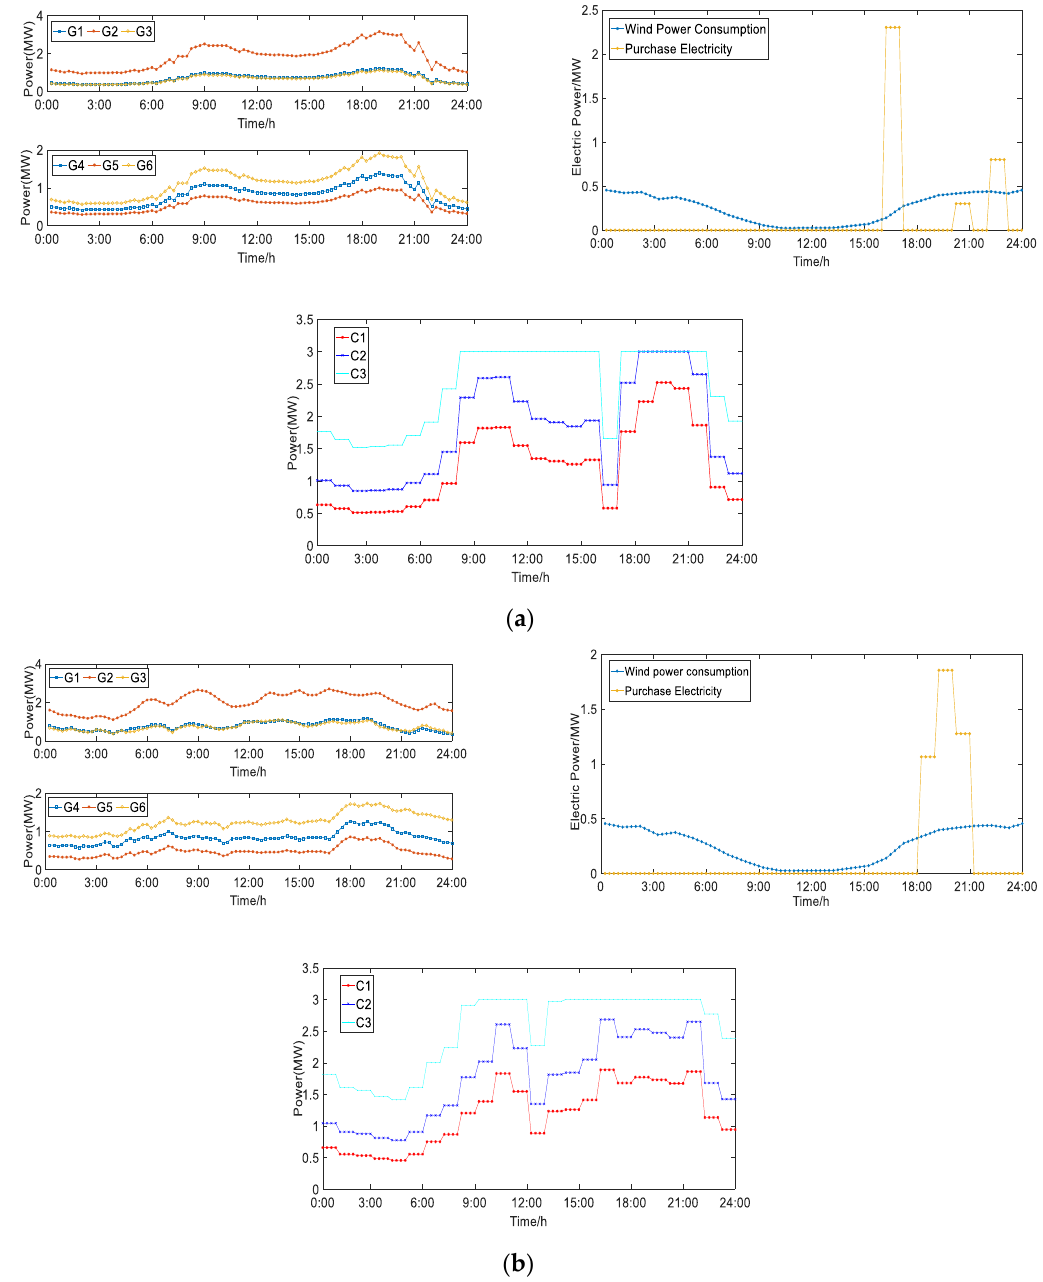
Figure 14. Electrical power balance. ( a ) T c = 3 h. ( b ) T c = 1